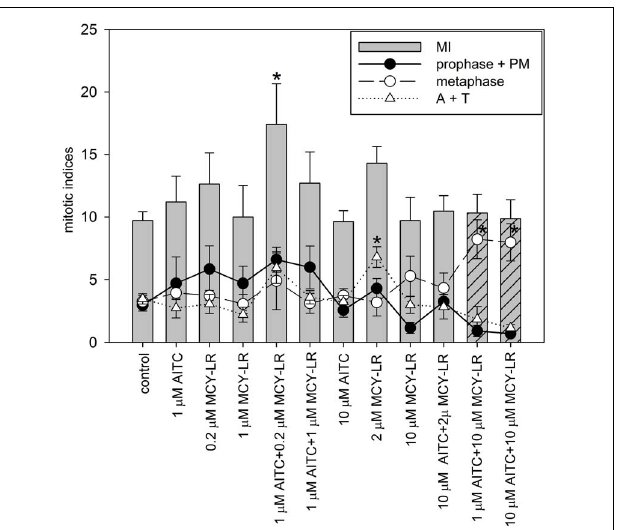
FIGURE 2 | Effects of AITC and MCY-LR on the mitotic activity of non-synchronized V. faba lateral root tip meristematic cells. MI in legend is the total mitotic index, PM: prometaphase, A+T: late mitotic (anaphase + telophase) index. ∗ Significant differences of treatments to controls ( P < 0.05), n ≥ 12. MIs (columns) for the combined treatments of 1 and 10 µ M AITC + 10 µ M MCY-LR are dashed to highlight their importance